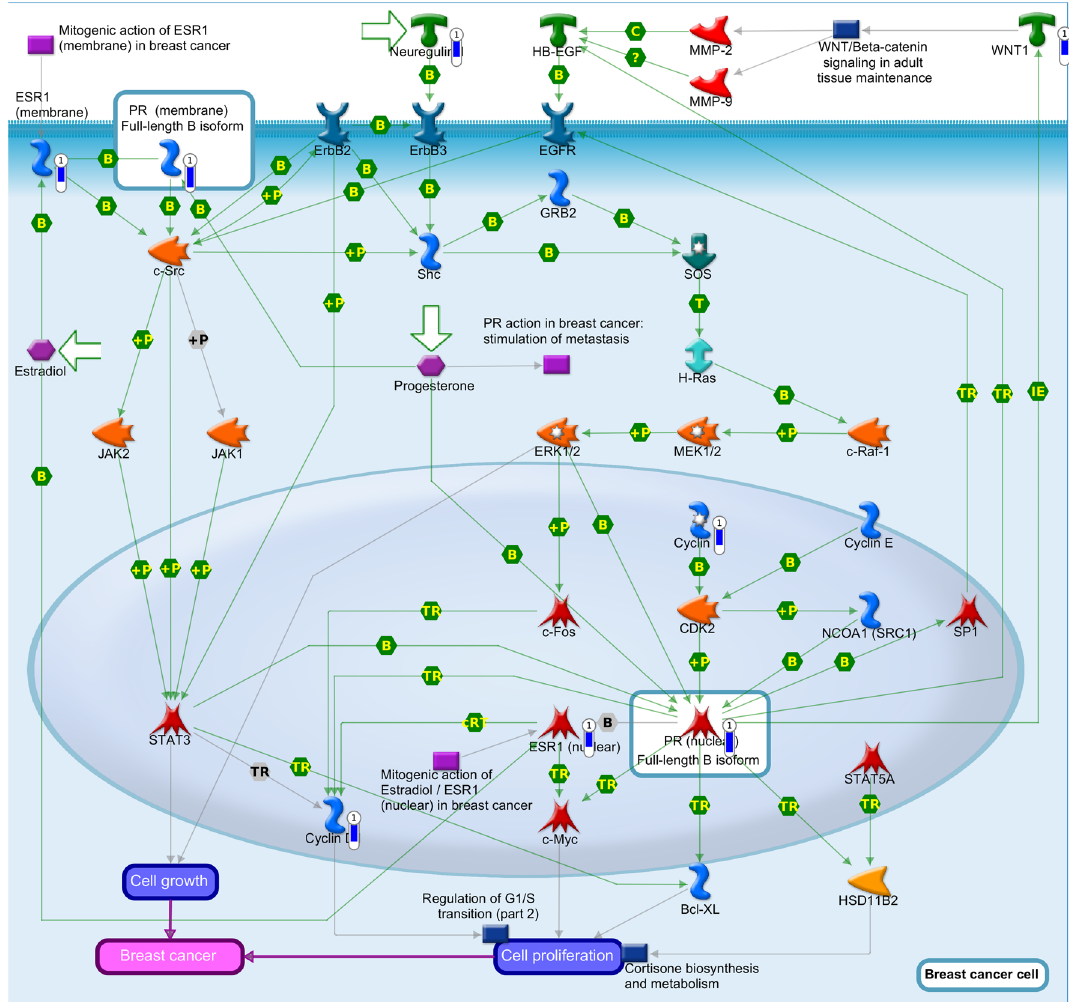
Figure 8. In silico analysis using MetaCore software. The pathway “PR action in breast cancer stimulation of cell growth and proliferation” was associated with differentially expressed genes related to NRIP1 silencing. Downregulated genes are marked with blue